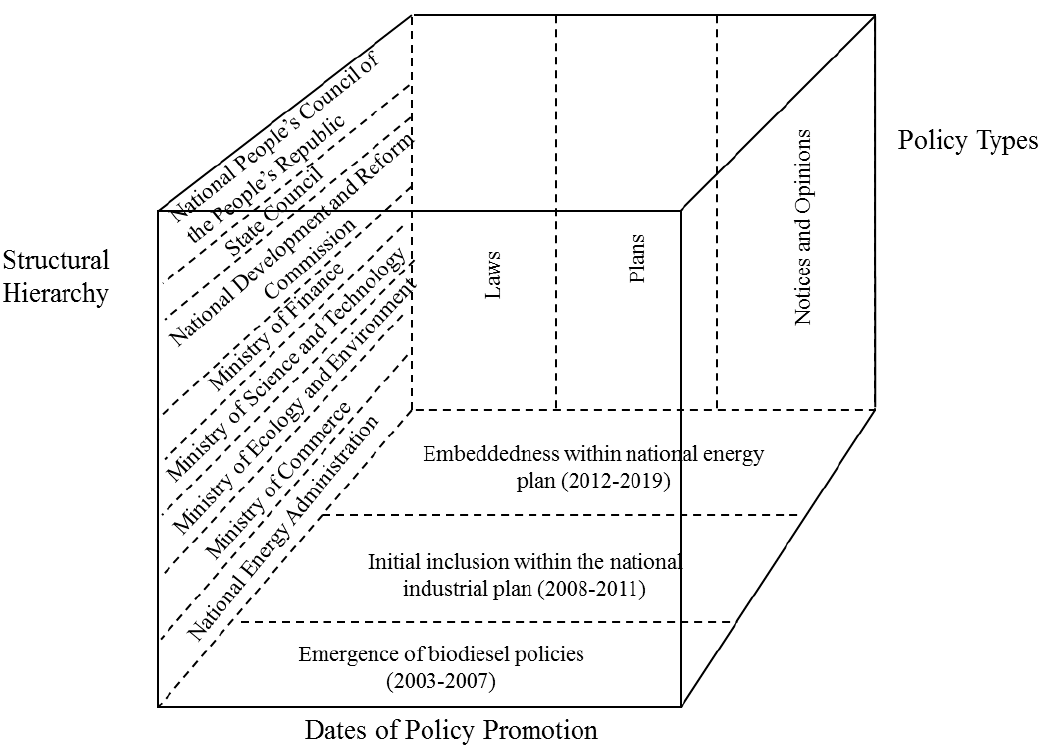
Figure 1. Analytical framework for policy texts.